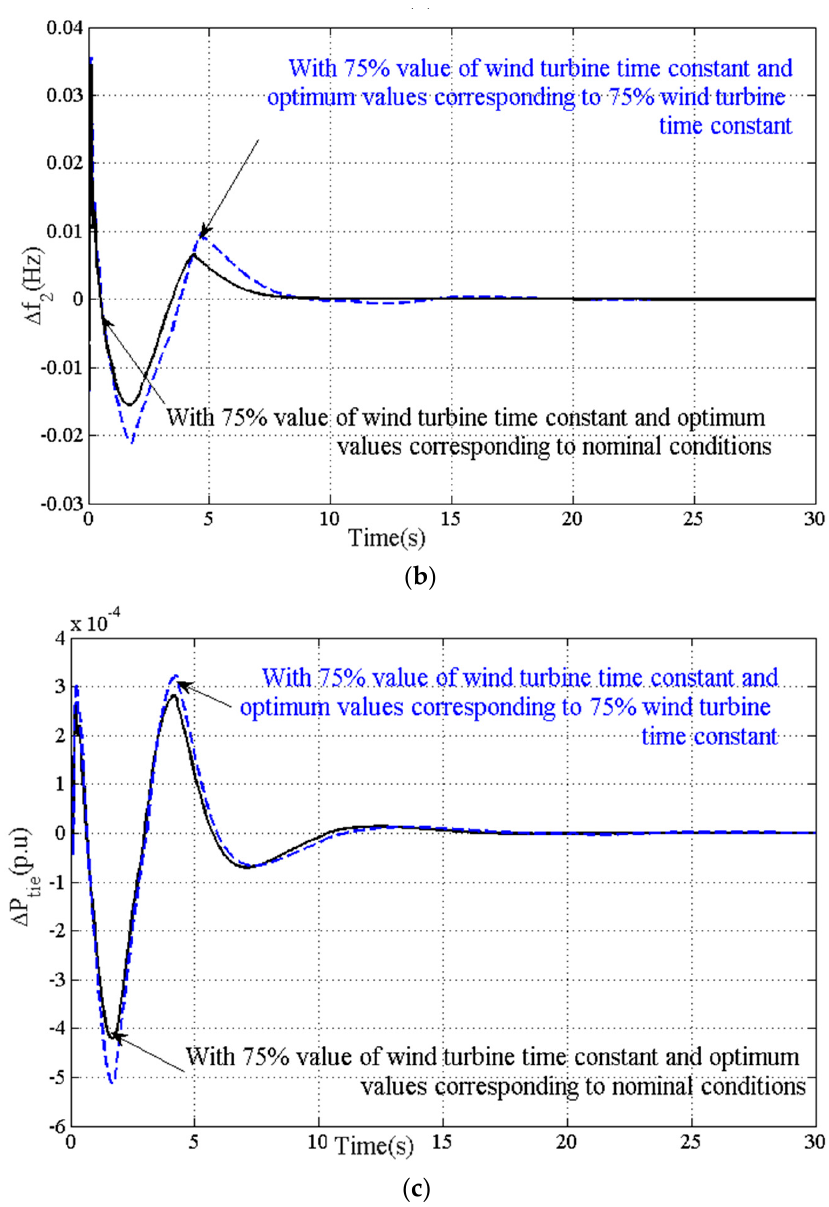
Figure 16. Insensitiveness of PID controller with − 25% variations in WTs time constant. ( a ) ∆ f 1 ; ( b ) ∆ f 2 ; and ( c ) ∆ P tie .